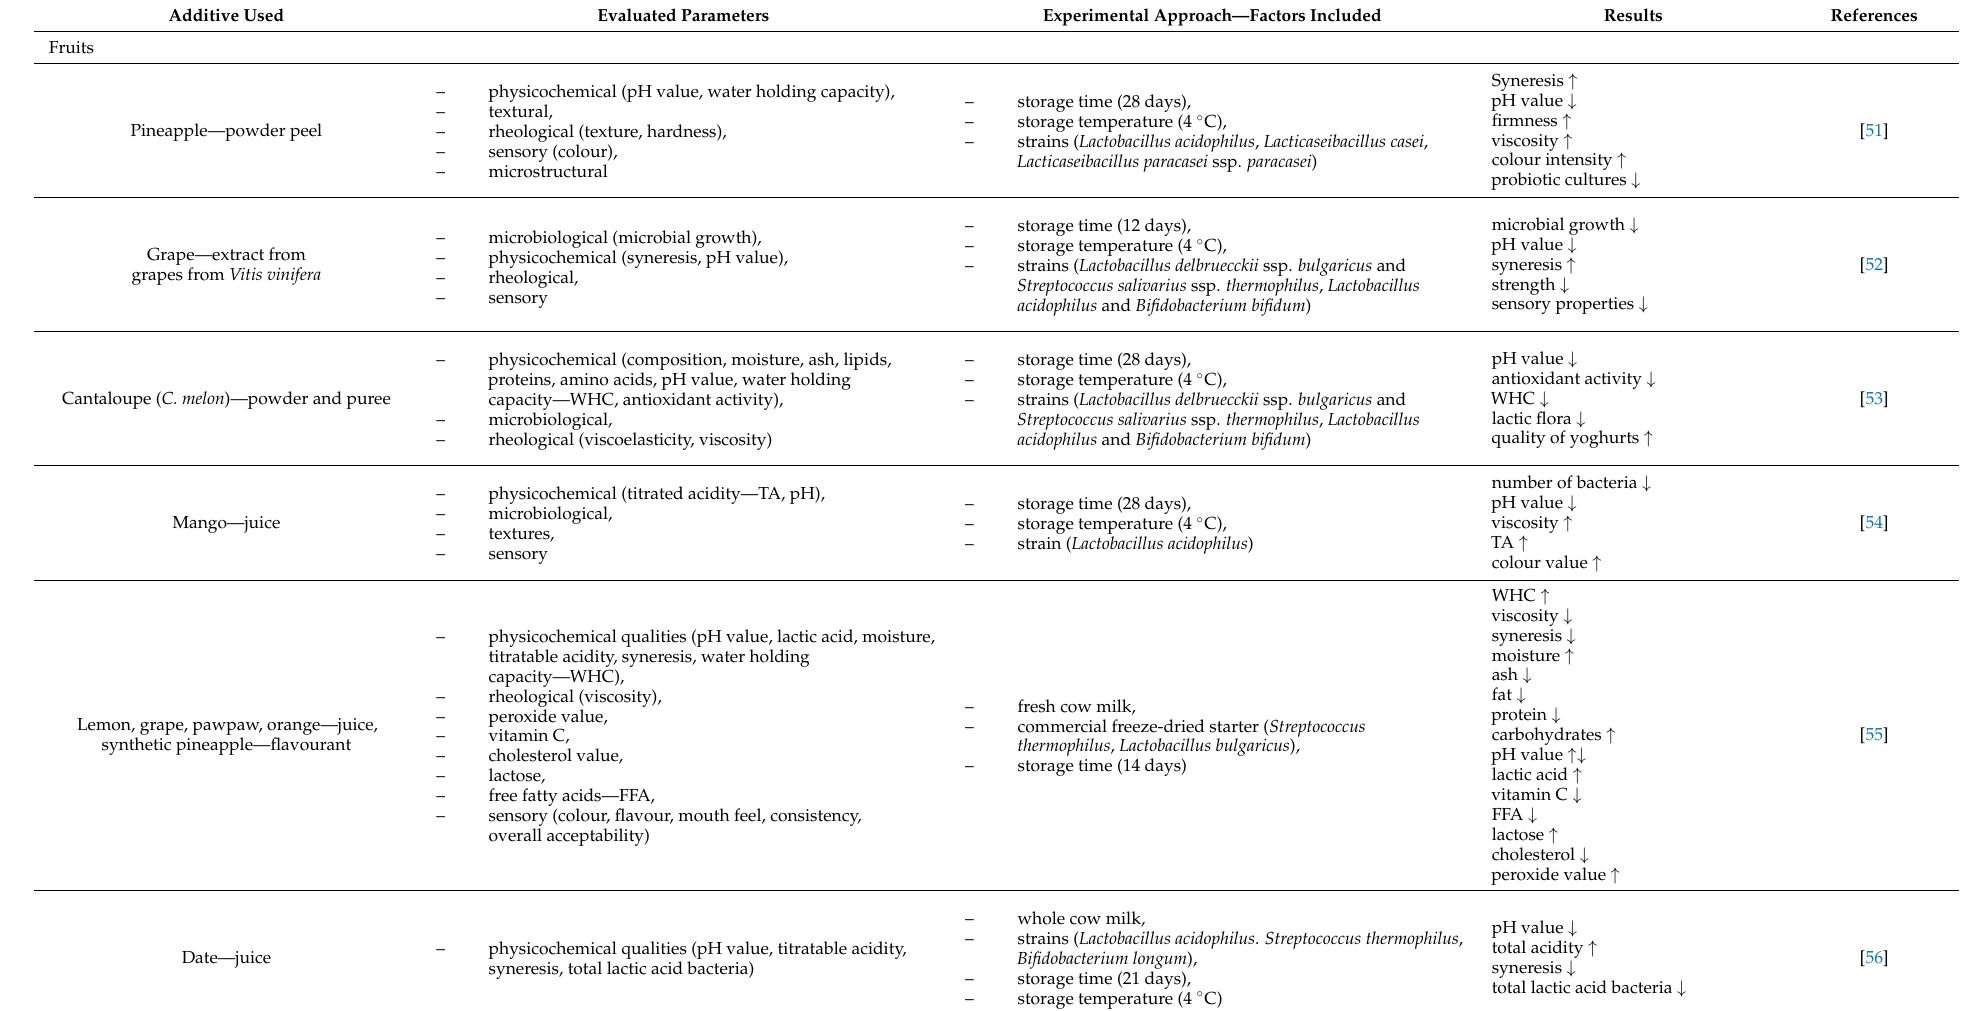
Table 3. Selected studies on the yoghurts with the plant-based